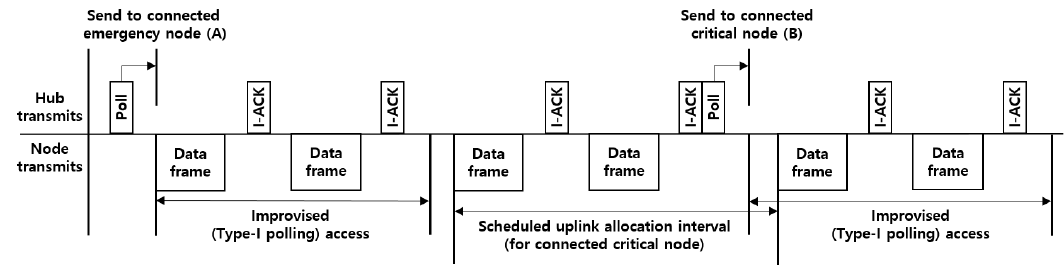
Figure 12. Frame transactions for improvised access in